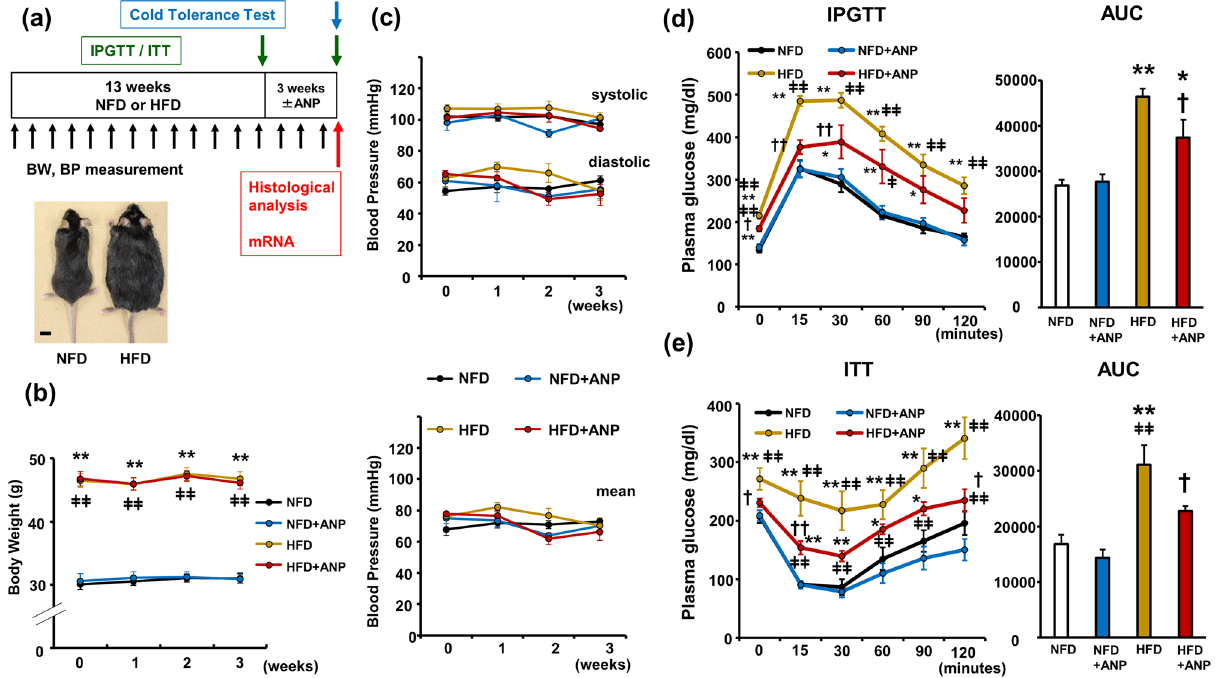
Figure 1. Effects of ANP treatment on HFD-induced obesity and insulin resistance. ( a ) A schematic diagram of the experimental protocol and appearance of the obese mice after 13 weeks of HFD feeding. Bars = 1 cm ( b ) body weight changes during ANP treatment (n = 15 each). ( c ) Blood pressure changes during ANP treatment (n = 9 each). Plasma glucose levels during IPGTT ( d ) and ITT ( e ) at three weeks after treatment with or without ANP ((d) NFD and HFD, n = 8 each; NFD + ANP, n = 9; HFD + ANP, n = 7. (e) NFD, NFD + ANP and HFD, n = 9; HFD + ANP, n = 8.). The area under the curve (AUC) was calculated from the plasma glucose levels profile shown in each test. Data are mean ± SEM. * P < 0.05 and ** P < 0.01 versus NFD at each time point; † P < 0.05 and †† P < 0.01 vs. HFD at each time point; ǂ P < 0.05 and ǂǂ P < 0.01 versus NFD + ANP at each time point. ANP,